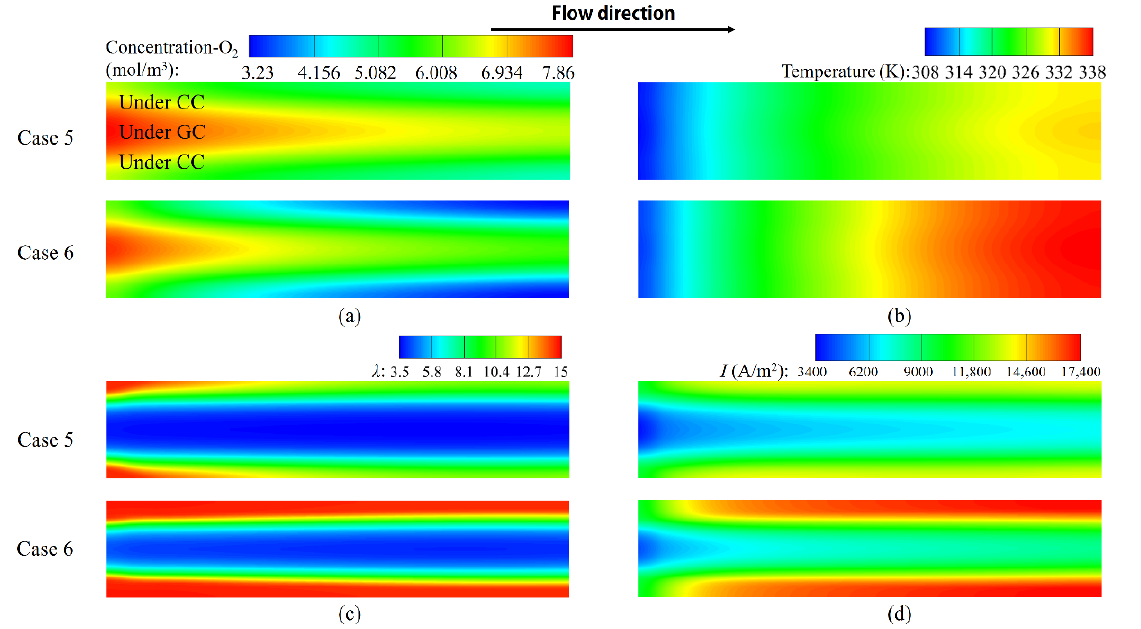
Figure 6. Comparison of key variable distribution in Cases 5–6 with GDL of through-plane gradient PTFE doping: ( a ) oxygen concentration ( b ) temperature, ( c ) dissolved water content and ( d ) current density distribution in the middle plane of CCL.